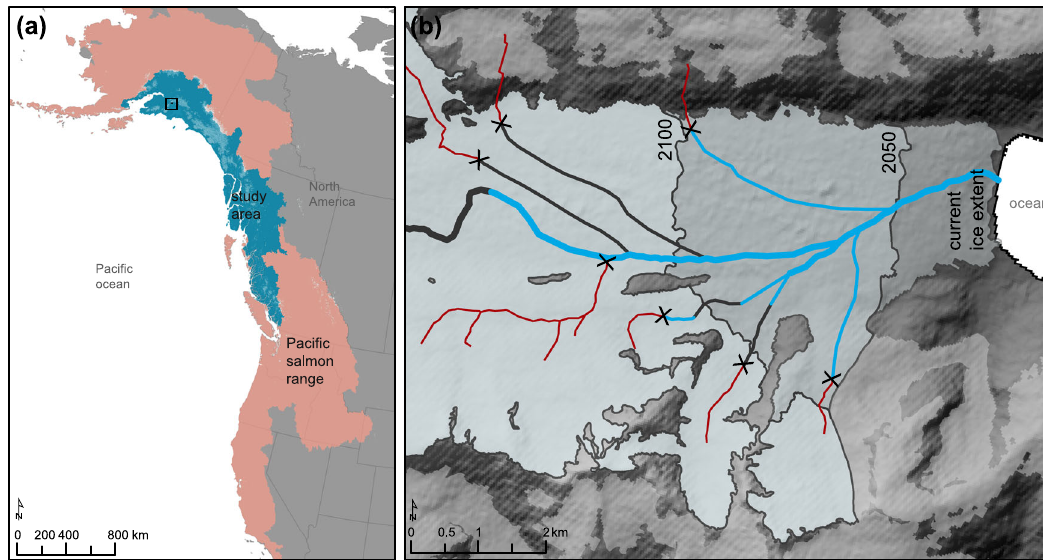
Fig. 1 Paci fi c salmon range in glacierized watersheds and how glaciers will create new streams. a Map showing the Paci fi c salmon range in North America (pink), and our study region (blue). Glacier outlines are in grey. The black box indicates the location of example focal area, shown in b Harriman Glacier, Prince William Sound, Alaska, showing approximate glacier retreat (for the benchmark years 2050 and 2100), future salmon-accessible streams (<10% stream gradient threshold over ~500 m; blue and black), and suitable habitat below a 0 – 2% stream gradient over ~500 m (blue). Thicker lines represent higher stream orders and narrower lines represent lower stream orders. Streams >10% stream gradient threshold are marked with an X and colored in